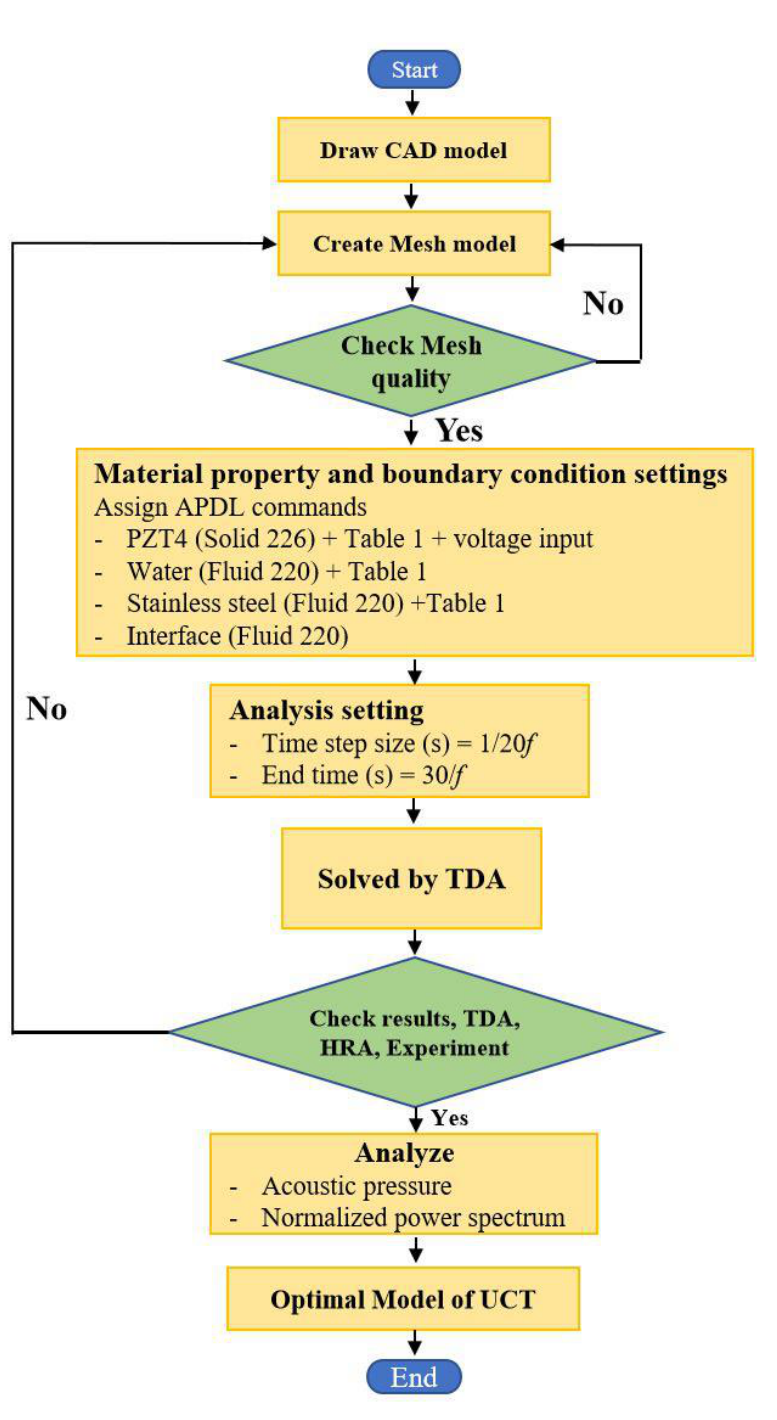
Figure 4. Flowchart of methodology.